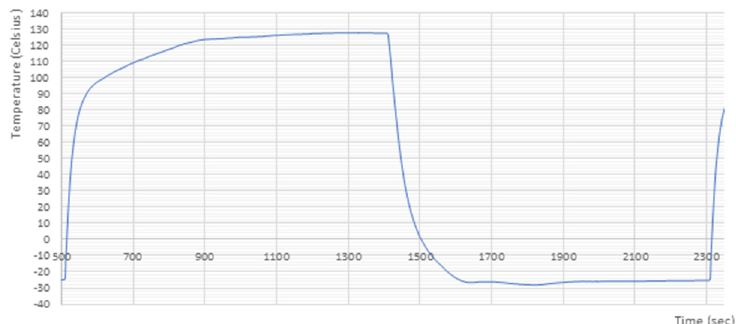
Figure 1. Thermal cycling profile applied to the cut-out samples.